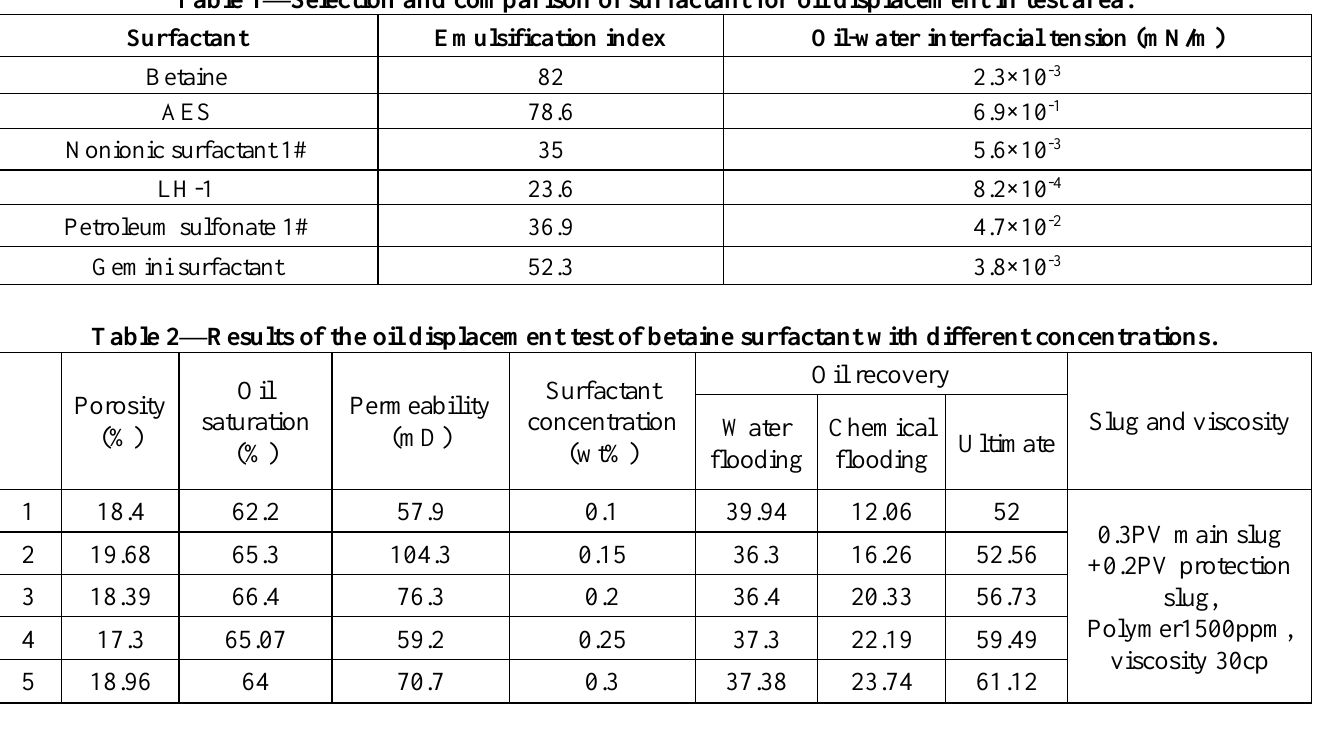
Table 1—Selection and comparison of surfactant for oil displacement in test area.